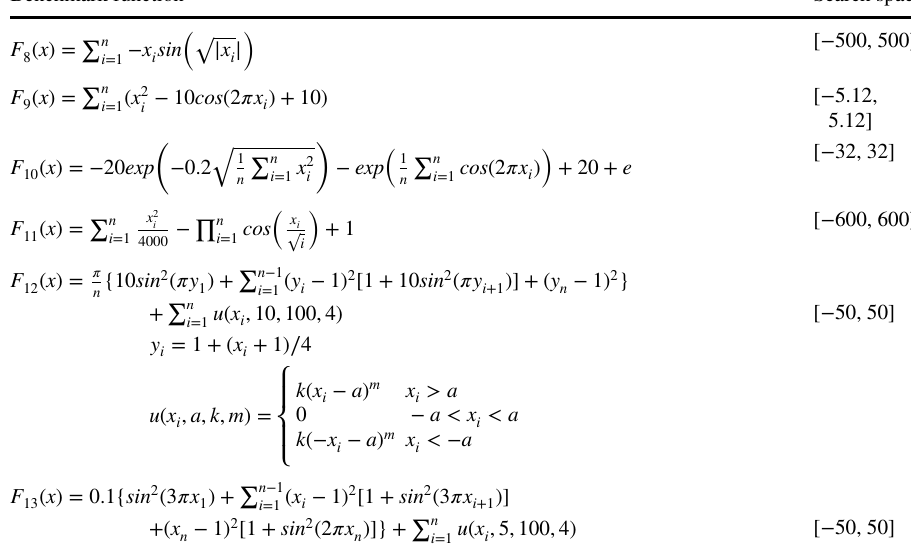
Table 2 Multimodal multi- dimensional benchmark functions